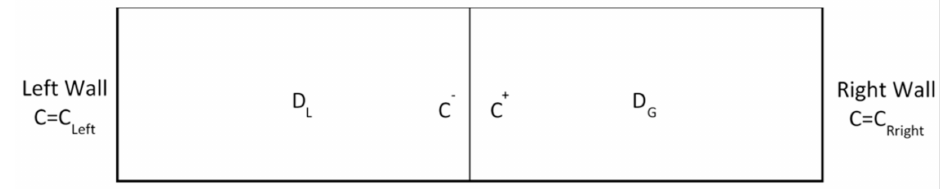
Figure A1. Schematic figure for a finite tube with defined concentrations on the wall. The grid blocks are assumed to be 1000 × 40 with a total number of 40,000. The left and right boundary conditions are assumed to be 1 and 0; respectively, with a diffusion coefficient of 2 m 2 /s and 1 m 2 /s. The simulation continued until it reached a steady-state condition. The numerical results are compared with the analytical solution in Figure A2. with analytical